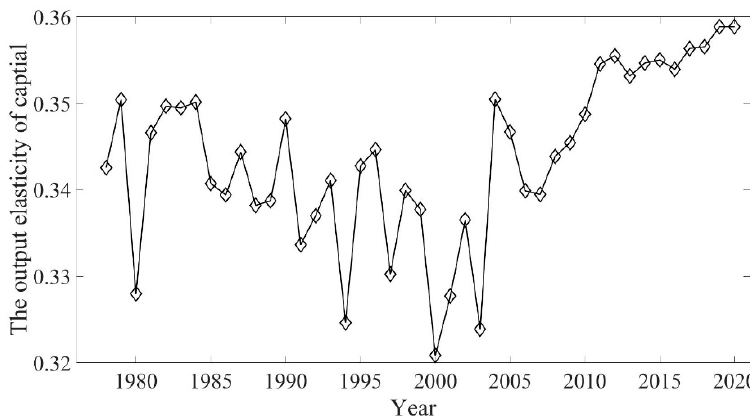
Figure 2. The output elasticity of capital from 1978 to 2020.